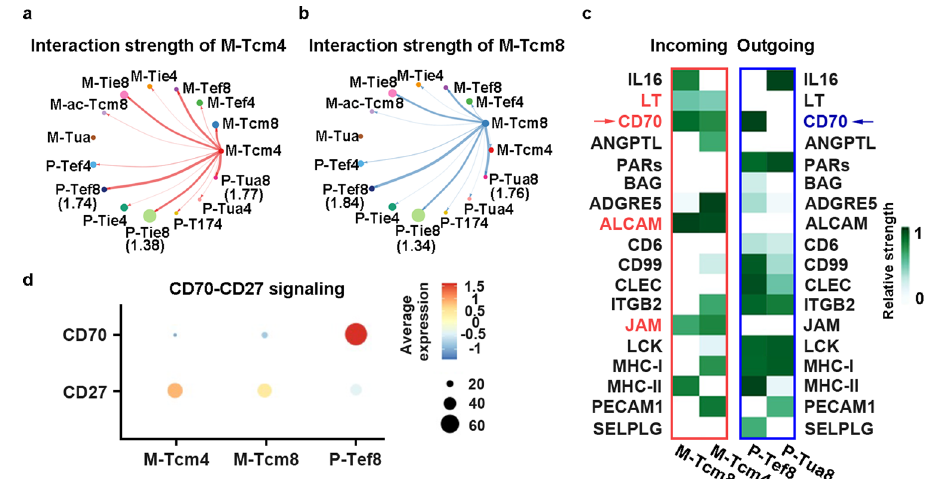
Fig.5|QuantitativeanalysisofintercellularcommunicationbetweenCARMzT and CARP T cells. a , b The inferred interaction strength of CD4 + central memory CARMz T cells (M-Tcm4) and CD8 + central memory CARMz T cells (M-Tcm8) with other cell clusters from CARMz T and CARP T cells. The top three interaction strength were shown with numbers that indicate the strength of interactions in SupplementaryTable1. c Heatmapshowstheinferredincomingsignalingpathways of M-Tcm4 and M-Tcm8 and outgoing signaling pathways ofP-Tef8 and P-Tua8 by